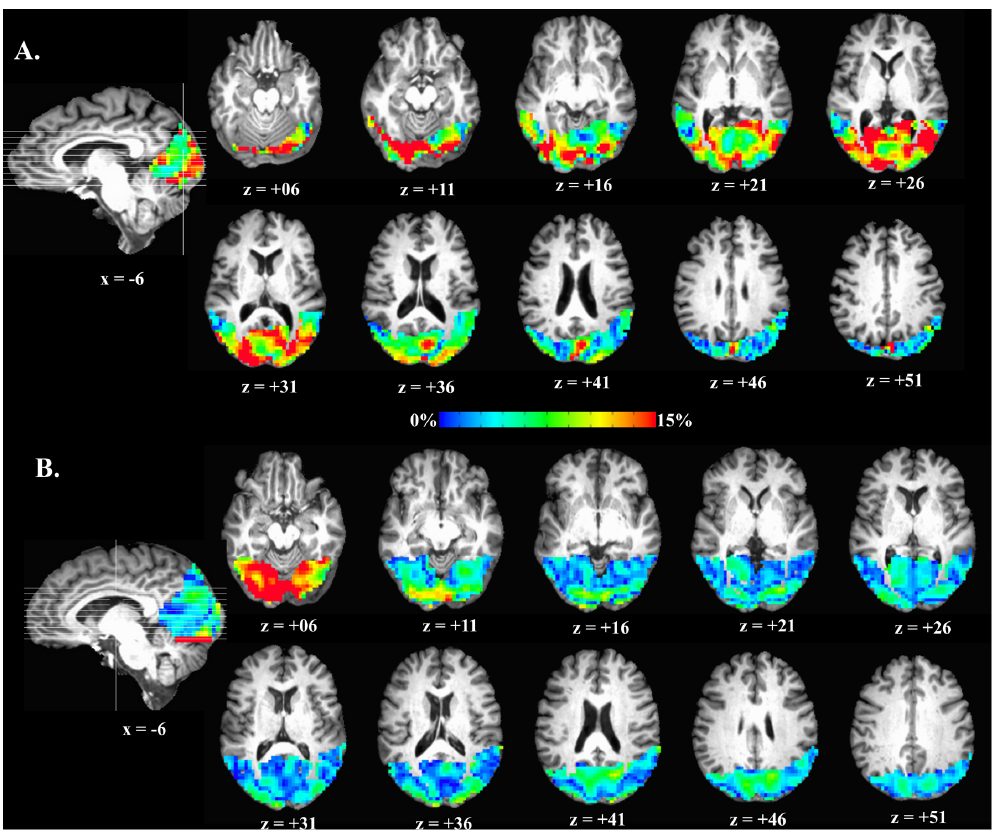
Figure 2. Examples of oxygen metabolism changes ( ∆ CMRO 2 )in occipital lobe. ( A ) HC ∆ CMRO 2 . ( B ) MS patient ∆ CMRO 2 . x = right-left, z = superior-inferior. ( B ) MS patient ∆ CMRO 2 . x = right-left, z =